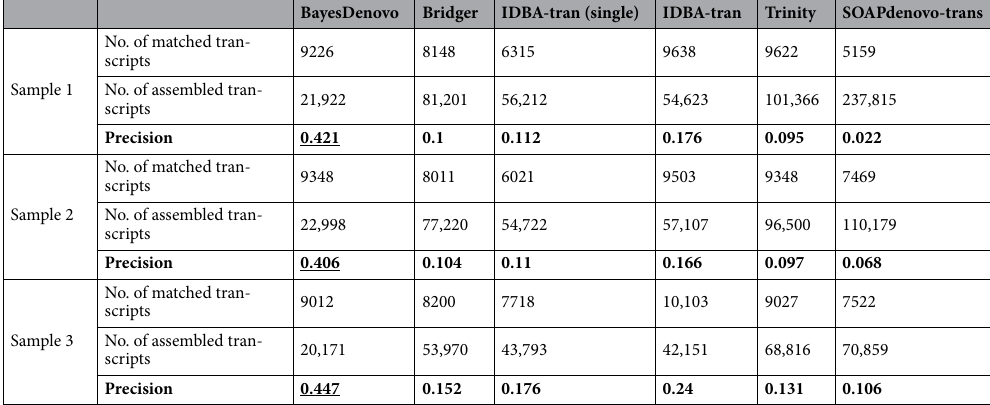
Table 1. Performances of the assemblers on MCF-7 breast cancer cell line RNA-seq data. Bold numbers show the metric where BayesDenovo significantly outperforms existing methods. Bold underline numbers highlight the performance of BayesDenovo.